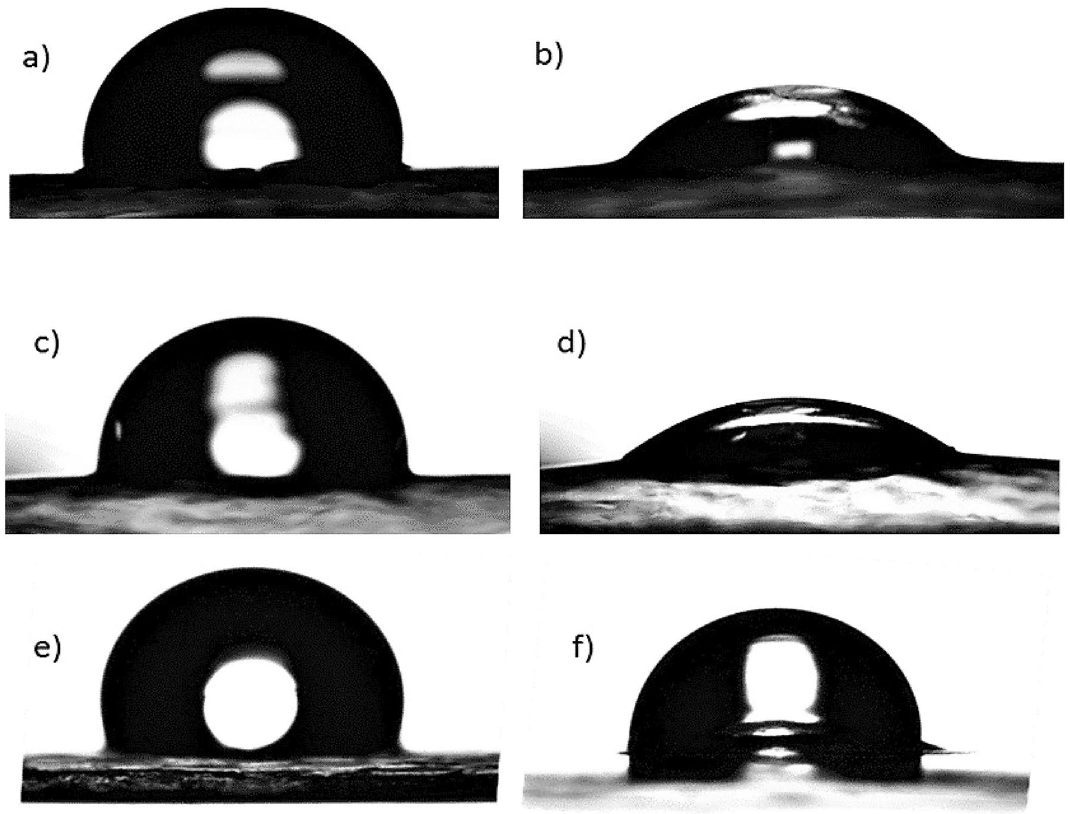
Figure 6. Representative images of surface contact angle measurements on cellulose-APP composites coated with ( a ) E2CA/10 s, ( b ) E2CA /15 min, ( c ) TOS-EtOH/10 s, ( d ) TOS-EtOH/15 min, ( e ) TOS-Toluene/10 s and ( f ) TOS-Toluene /15